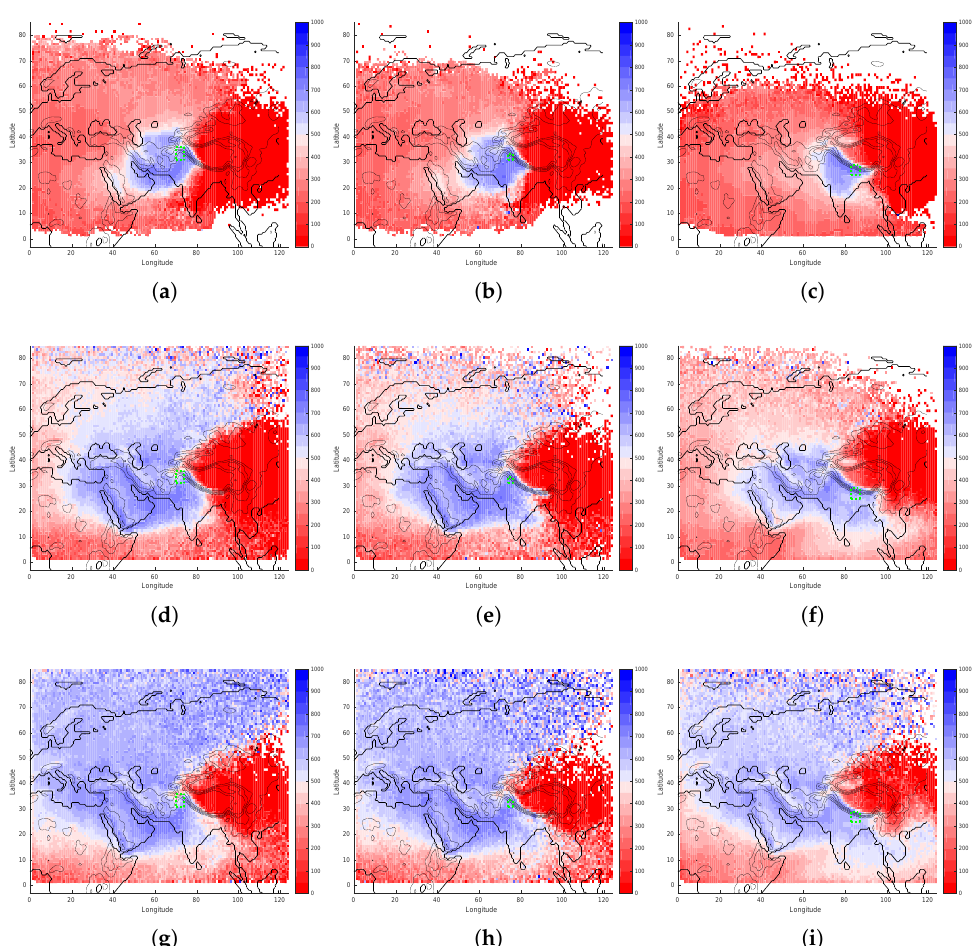
Figure 8. Winter (NDJ) column mean climatology (1980–2016), of the parcel pressures, for all parcels over each 1 ◦ area, originating from: ( a ) NP , 2 days back in time, along the parcel trajectory; ( b ) U , 2 days back in time, along the parcel trajectory; ( c ) K , 2 days back in time, along the parcel trajectory; ( d ) NP , 6 days back in time, along the parcel trajectory; ( e ) U , 6 days back in time, along the parcel trajectory; ( f ) K , 6 days back in time, along the parcel trajectory; ( g ) NP , 10 days back in time, along the parcel trajectory; ( h ) U , 10 days back in time, along the parcel trajectory; ( i ) K , 10 days back in time, along the parcel trajectory. The area of interest is illustrated by a green dashed